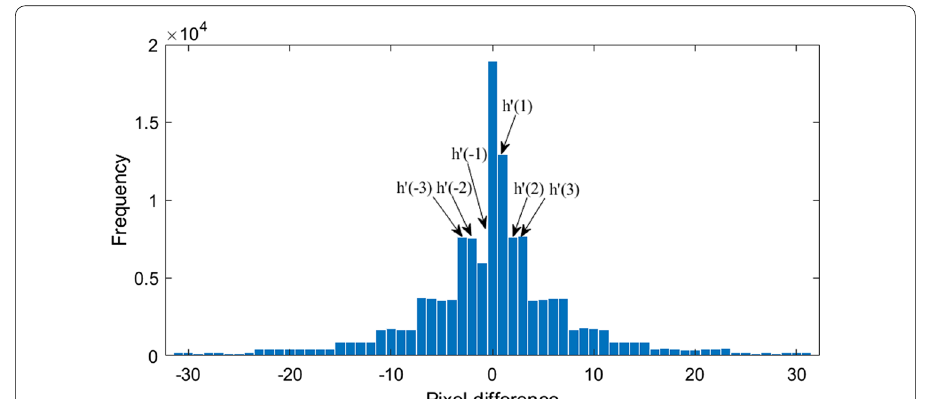
Fig. 5 PDH using PVD steganography with an embedding ratio of 100% (type 2 of the PVD interval)